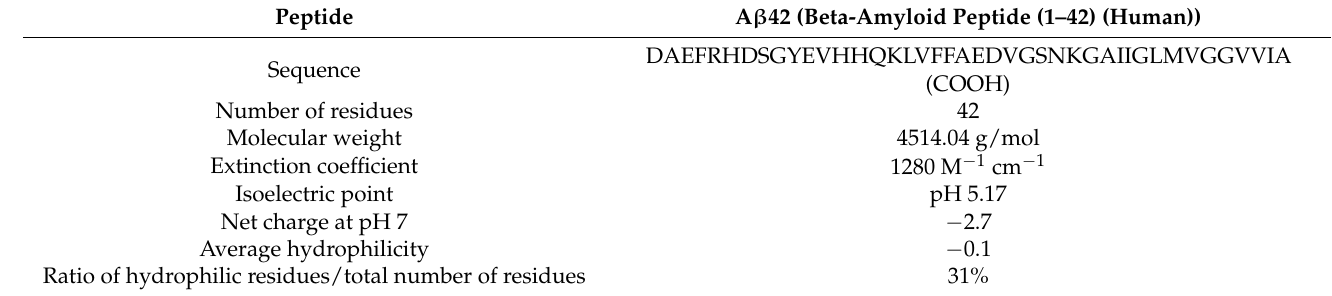
Table 1. Calculations and estimations on physiochemical properties of peptide A β 42 using the software Pepcalc.com (peptide property calculator) [25] and the Peptide Calculator from BACHEM [26].